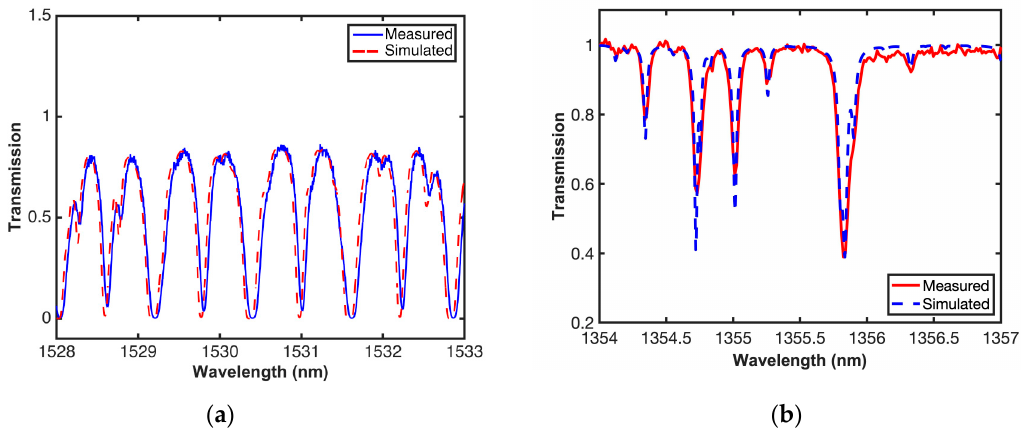
Figure 11. Simulated and simultaneously measured gas transmission of ( a ) acetylene and ( b ) water vapor.